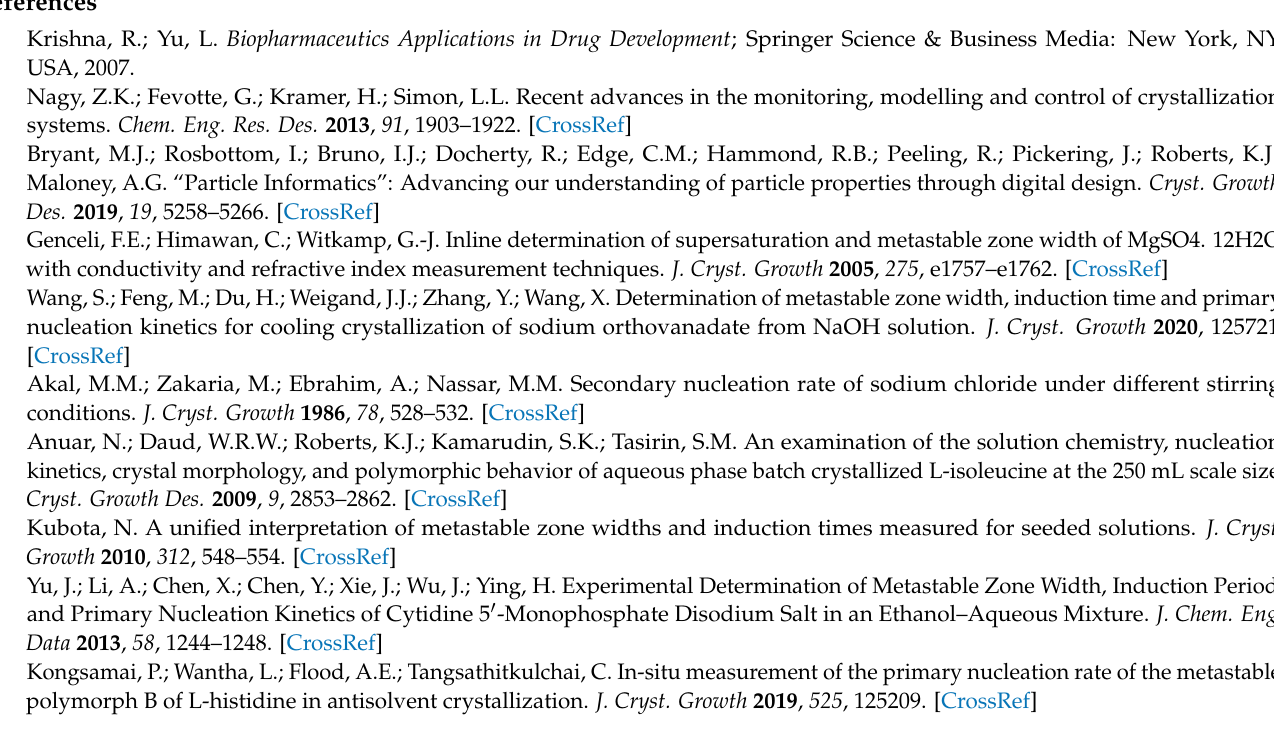
20 V solutions; Figure S3: Radial distribution function (RDF) showing the positions of atoms in the cell from an arbitrary reference atom; Table S1: Detailed parameters used for induction time determination in isothermal crystallisation experiments; S2: Theoretical background: nucleation parameter determination for polythermal crystallisation and Section S3: Theoretical background: nucleation parameter determination for isothermal